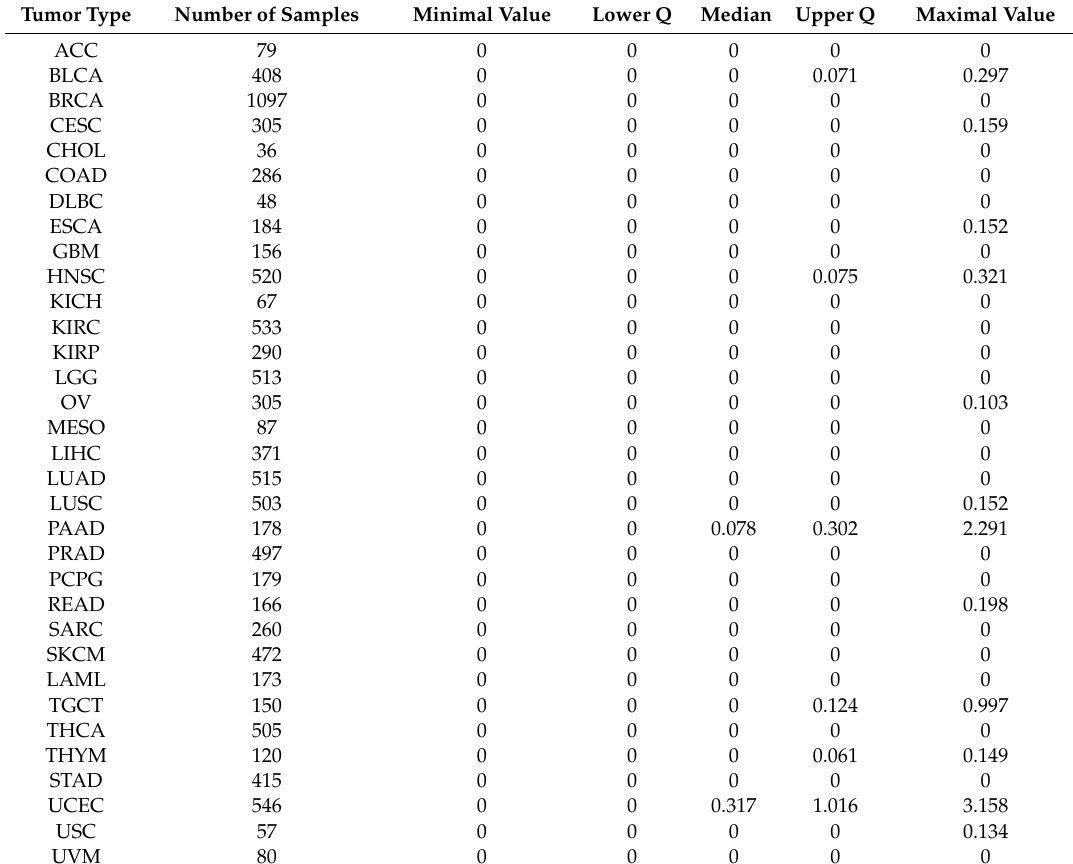
Table 1. Expression values of CGB1 in cancer samples deposited in TCGA. Q—quartile.